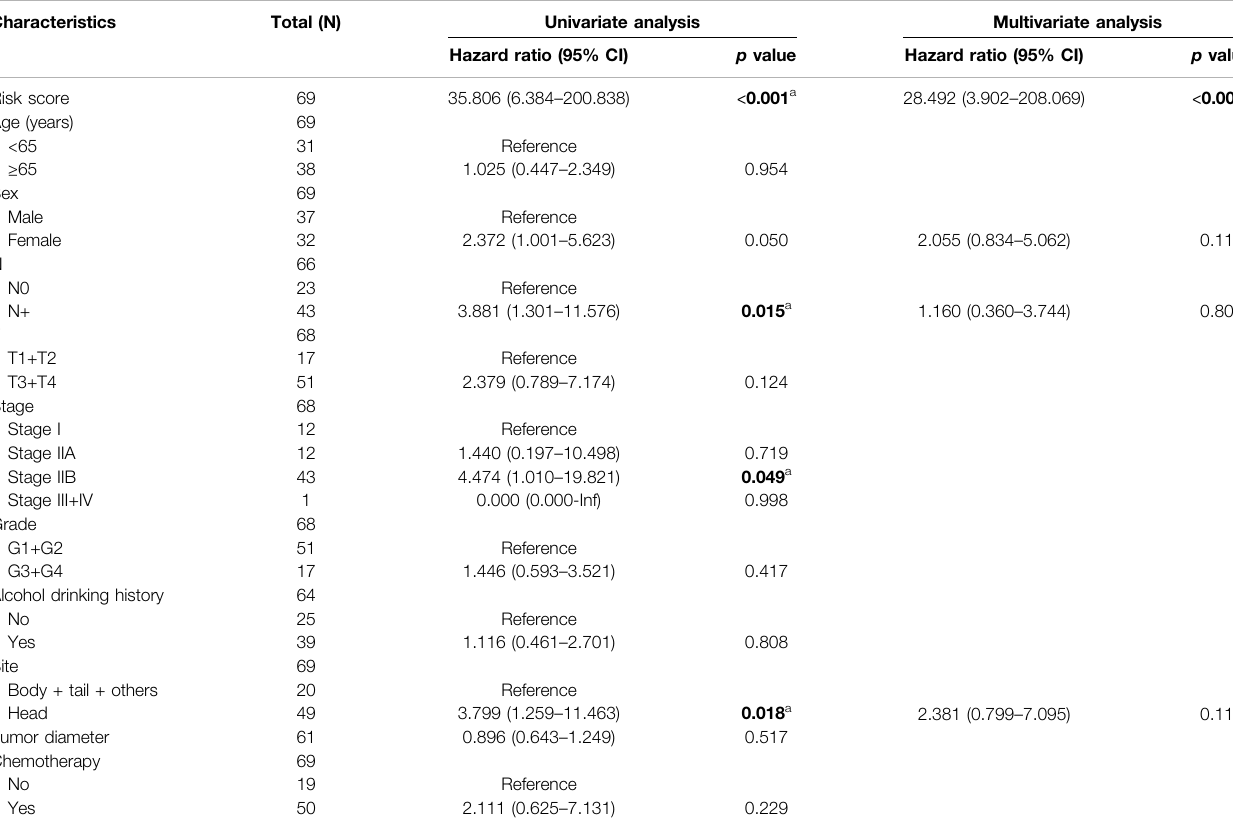
TABLE 2 | Independent prognostic factors for DFS in TCGA dataset.